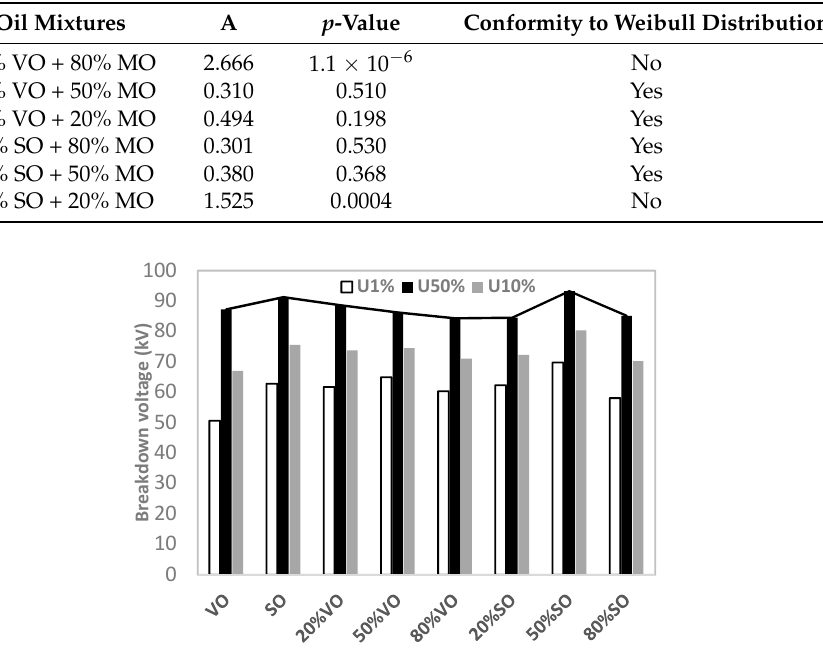
Figure 20. Probability of AC breakdown voltage of oil mixtures.